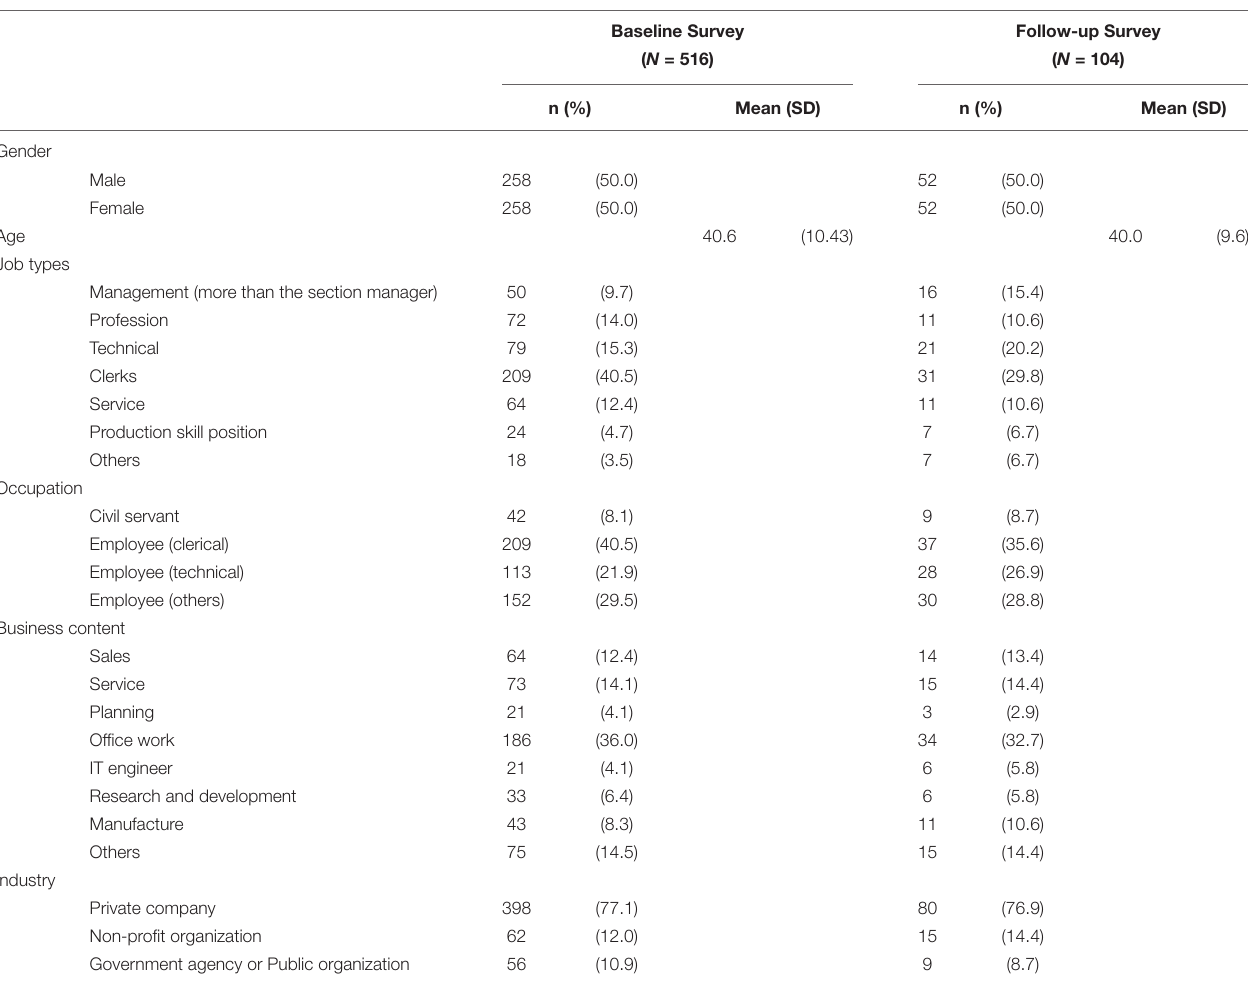
TABLE 2 | Demographic characteristics of participants and their supervisors.